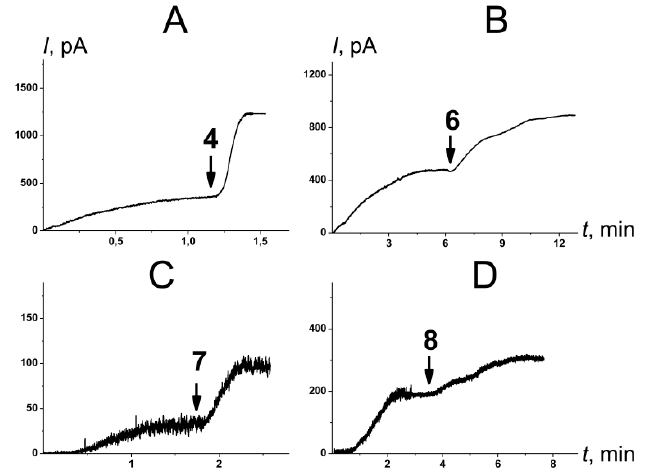
Figure 5. The effects of chromone-containing allylmorpholines ( 4 , 6 , 7 , 8 ) on the steady-state transmembrane current flowing through membranes modified by one-sided addition of AmB. The moments when 100 µg/mL of 4 ( A ), 6 ( B ), 7 ( C ), and 8 ( D ) was added to the bilayer bathing solution are indicated by arrows. The lipid bilayers were composed of POPC/CHOL (80/20 mol%) and were bathed in 2.0 M 4KCl, pH 7.4. V = 50 mV.